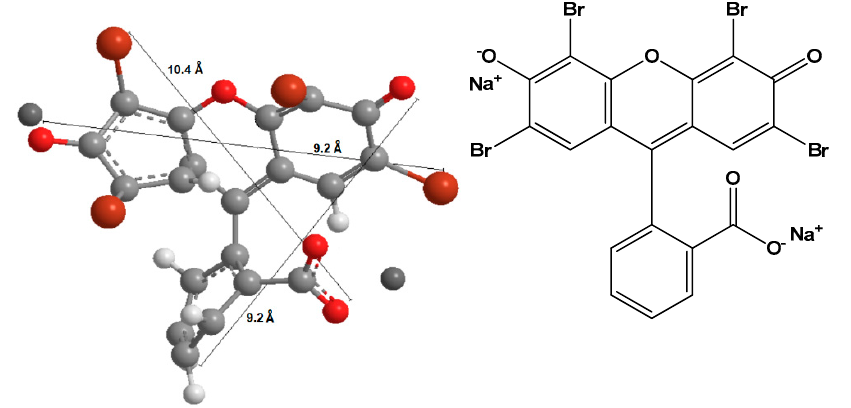
Figure 2. The chemical ( right ) and the optimized three-dimensional structure ( left ) of eosin Y.